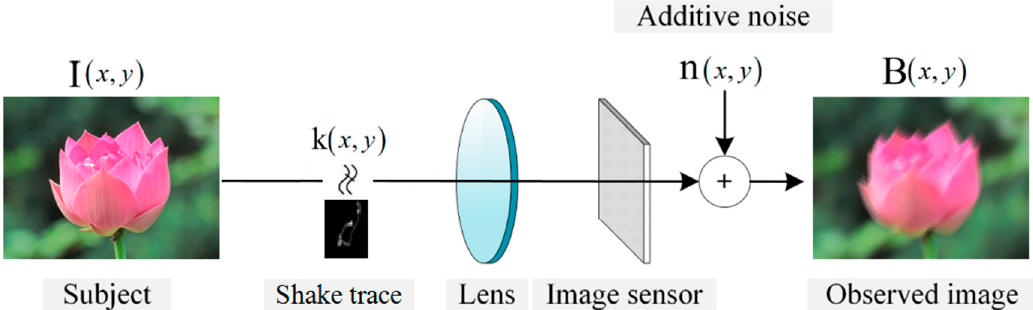
Figure 1. Image degradation model for motion blur of image sensor.